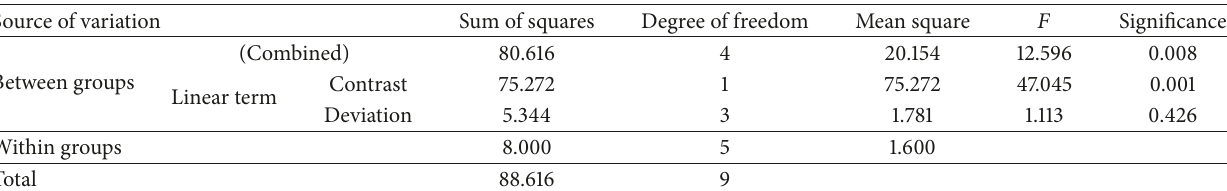
Table 6: ANOVA: single factor between the groups of different particle contents on viscosity.